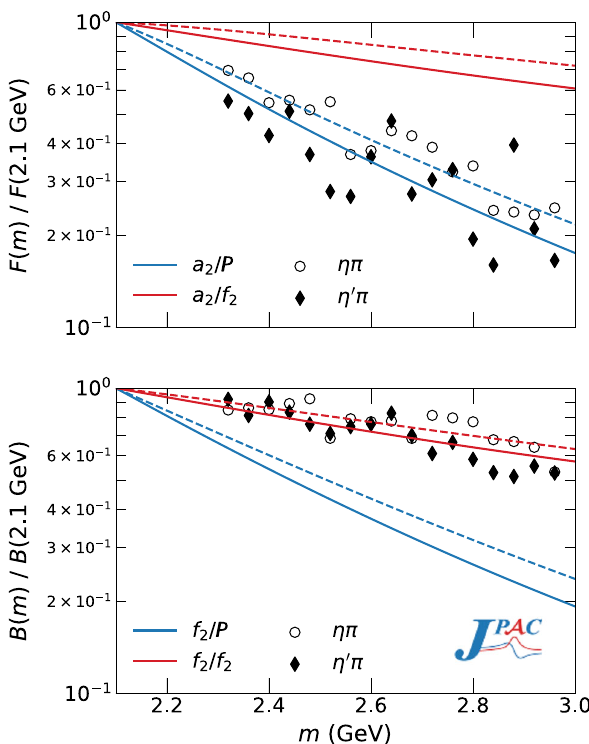
Fig. 8 Forward (upper) and backward (lower) intensities as defined in Eq. (5) for the top- a 2 and top- f 2 amplitudes, respectively. Solid lines correspond to ηπ and dashed to η (cid:2) π . Each theoretical intensity is nor- malized to its value at m = 2 . 1GeV. In circles and diamonds we show the experimental data arbitrarily rescaled, as obtained by